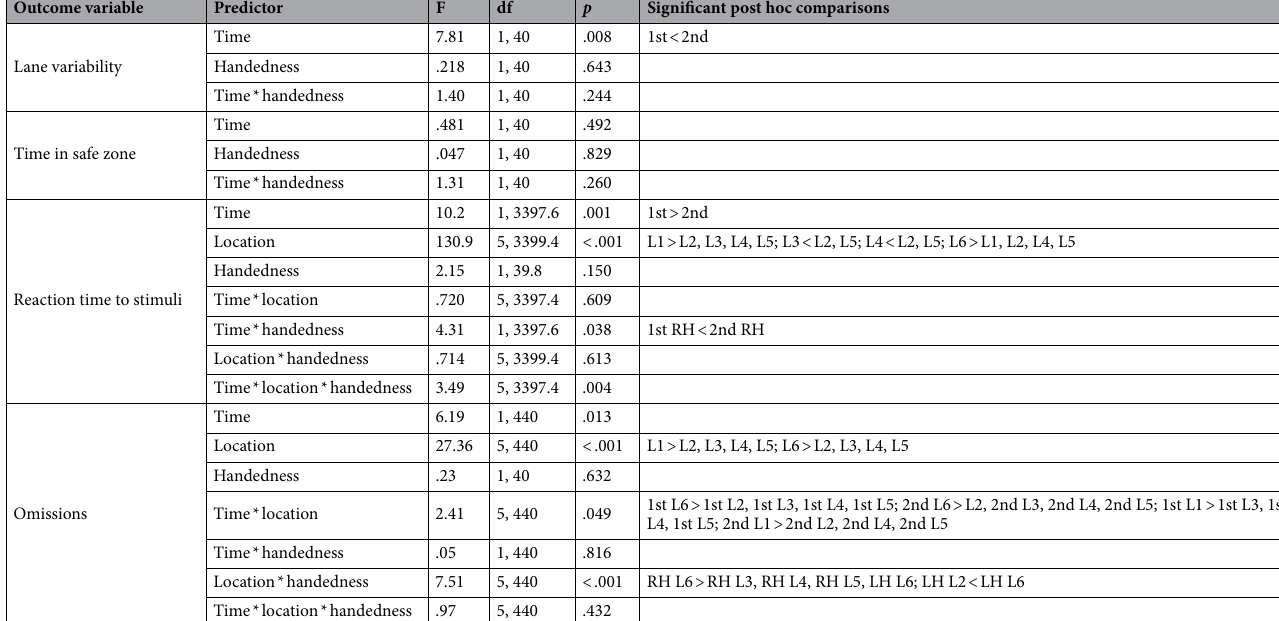
Left-handers seem to show the opposite reaction time pattern of right-handers: with slower reaction times to right-sided stimuli in the second compared to the first half of the drive. However, the differences at the rightmost lateral stimulus were statistically not significant for left-handers when the analyses were corrected for multiple comparisons ( p uncorrected = .017).